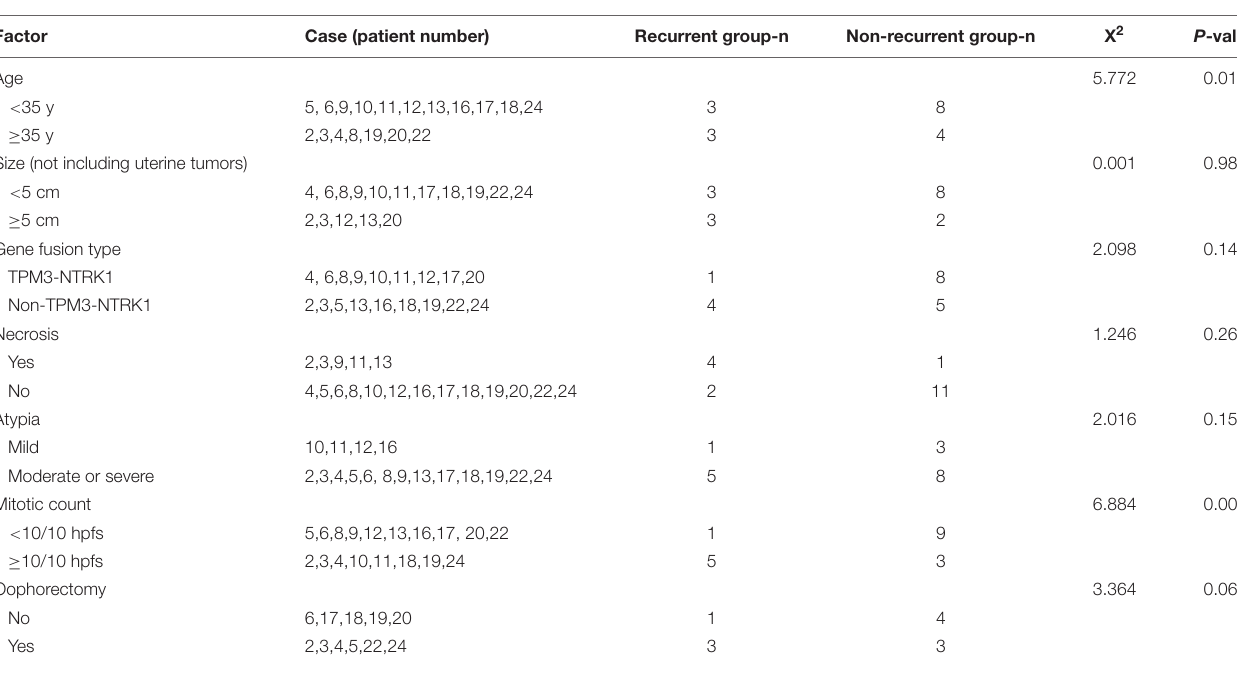
TABLE 1 | Univariate survival